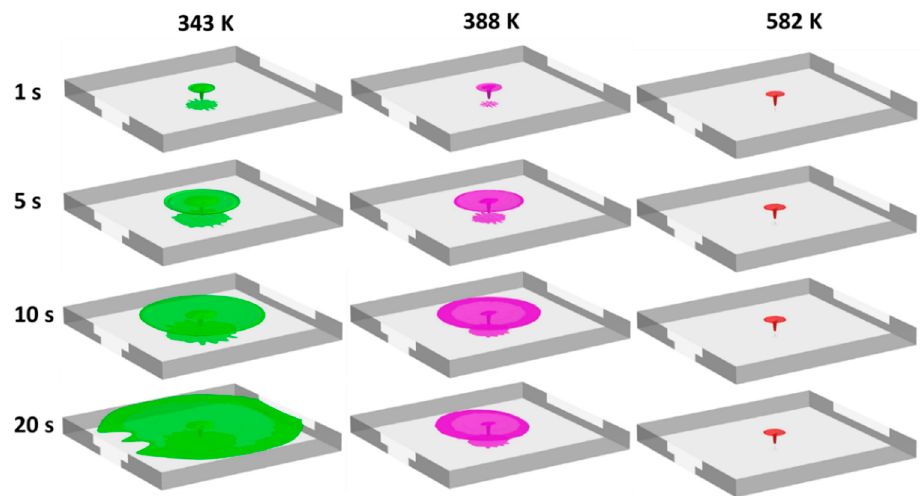
Figure 8. Iso-surfaces showing no-harm (343 K), pain limit (388 K) and fatality limit (582 K) temperature for ignited hydrogen release in case 7 (TPRD = 0.5 mm, upward release with tank blowdown from distance 2.1 m to the ceiling, no car body).